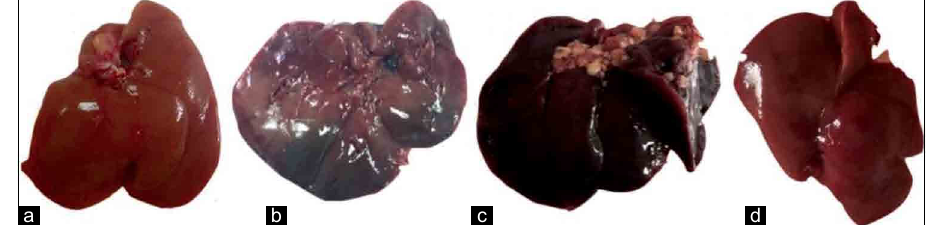
Figure-10: Macroscopical examination of liver in different Toxocara vitulorum -rat models. (a) Normal appearance of the liver of healthy control rat. (b) Hepatomegaly with sever congested dark borders were noticed in the liver of the untreated T. vitulorum -rat model. (c) Enlarged and congested liver of rats at 4 th week following albendazole administration. (d) Normal size and appearance of rat livers at the 4 th week after albendazole with BMMSCs therapy. BMMSCs=Bone marrow mesenchymal stem